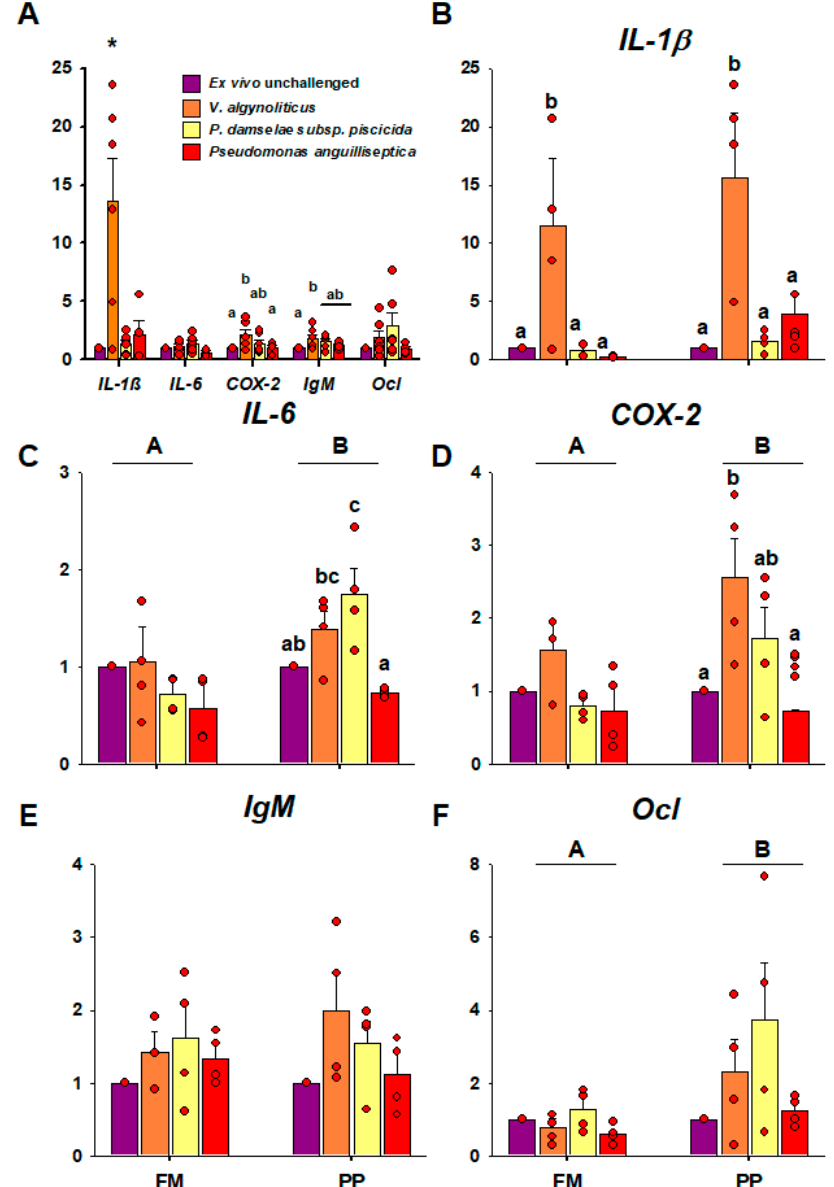
Figure 3. The e ff ect of bacterial challenge based on the diet after 6 h of ex vivo bacterial exposition in Phase I (68 g). Relative gene expression (A.U.) of the di ff erent genes is expressed by the mean and standard error. Capital letters indicate di ff erences between diets, meanwhile lowercase letters or asterisks indicate di ff erences between bacteria for each gene ( p < 0.05) after 6 h of incubation. ( A ) The e ff ect of bacterial challenge independent of diet. Gene expression of ( B ) IL-1 β , ( C ) IL-6 , ( D ) COX-2 , ( E ) IgM , and ( F ) Ocl based on the stimuli and diet. Sample data in each experimental group are represented by red spots. Photobacterium damselae subsp. Piscicida ( P. damselae subsp. Piscicida ); Pseudomonas anguilliseptica ( P. anguilliseptica ); Vibrio alginolyticus ( V. alginolyticus